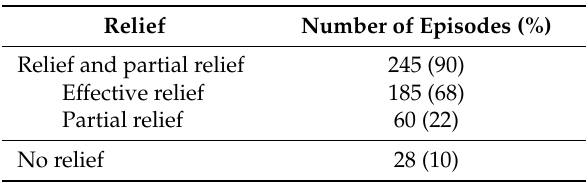
Table 4. Effectiveness of the OPD to relieve symptoms ( n = 273) 1 .